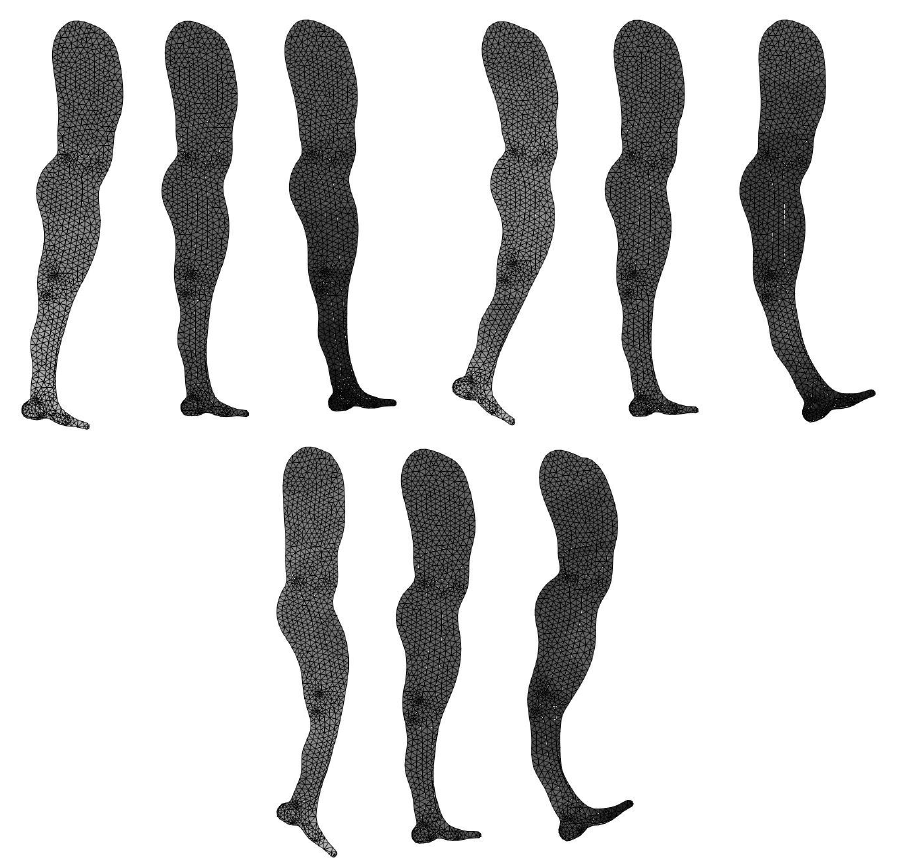
Figure 3. Mode shapes: (top) Frequency 1 (12.8 Hz); (middle) Frequency 2 (54.5 Hz); (bottom) Frequency 3 (126.9